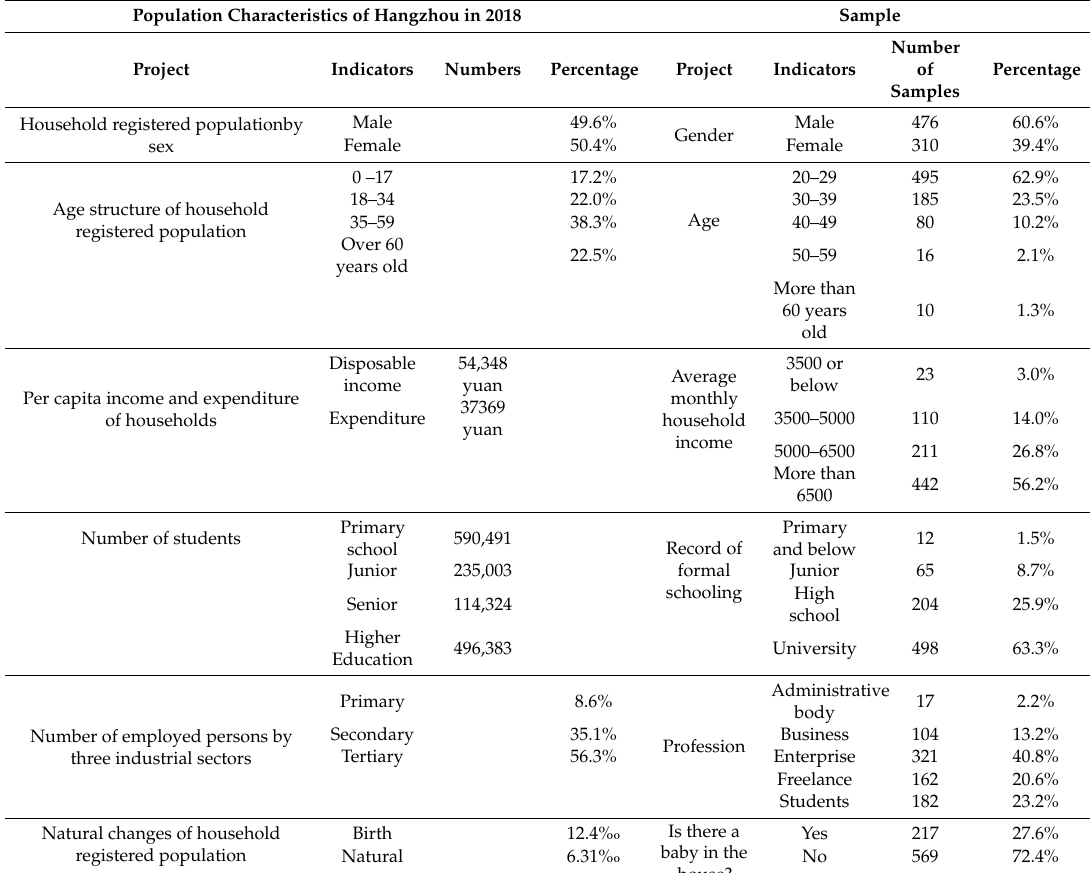
Table A1. Comparative analysis of sample and total